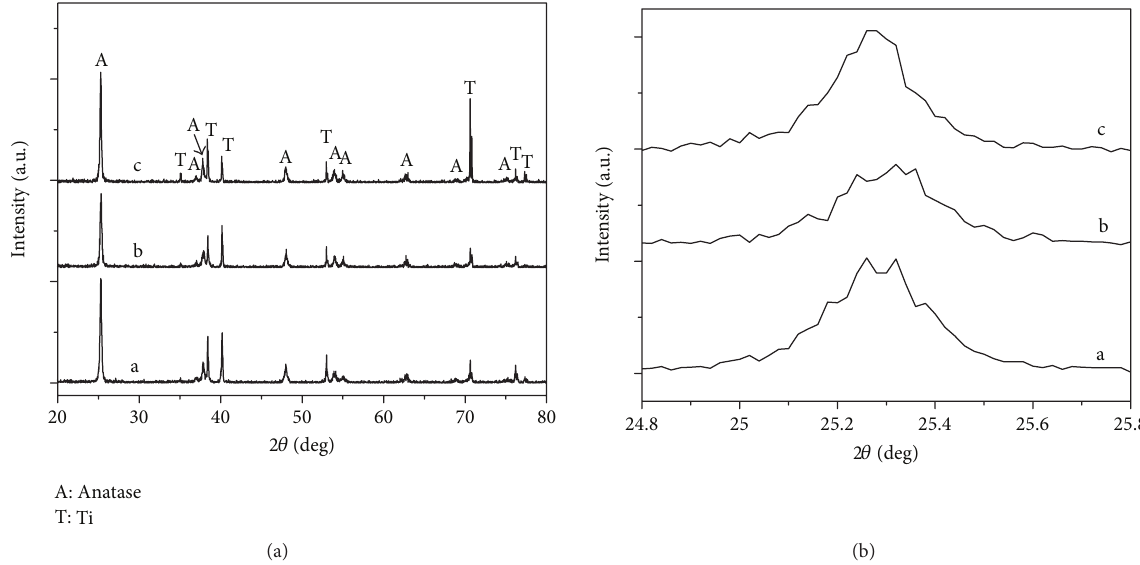
Figure 3: (a) X-ray diffraction pattern of photocatalysts (a: TNTs; b: 0.5M NiO/TNTs; c: 2.5 M NiO/TNTs) and (b) enlarged XRD peaks of crystal plane (1 0